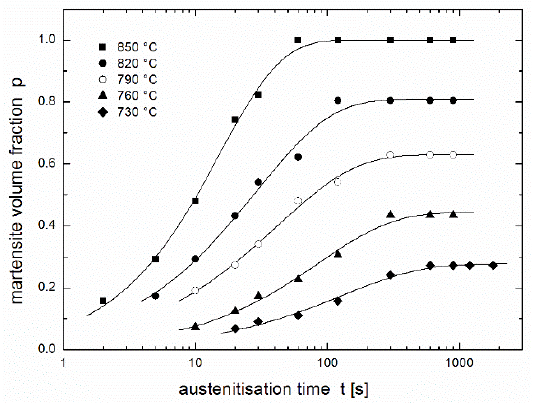
Figure 1. Martensite volume fraction in dual phase steel after austenitisation at various tempera- tures during various dwells [17] fitted using the JMAK Equation (4) (for each temperature sepa-